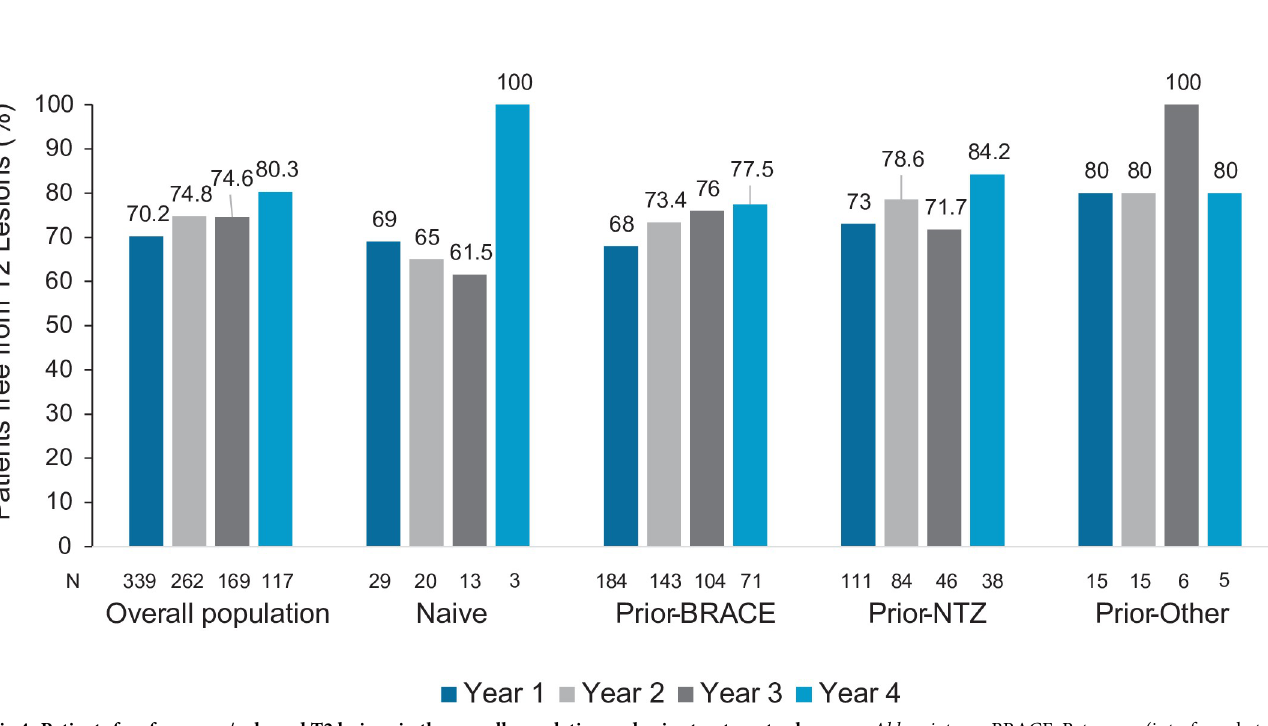
PLOS ONE | https://doi.org/10.1371/journal.pone.0258437 October 13,